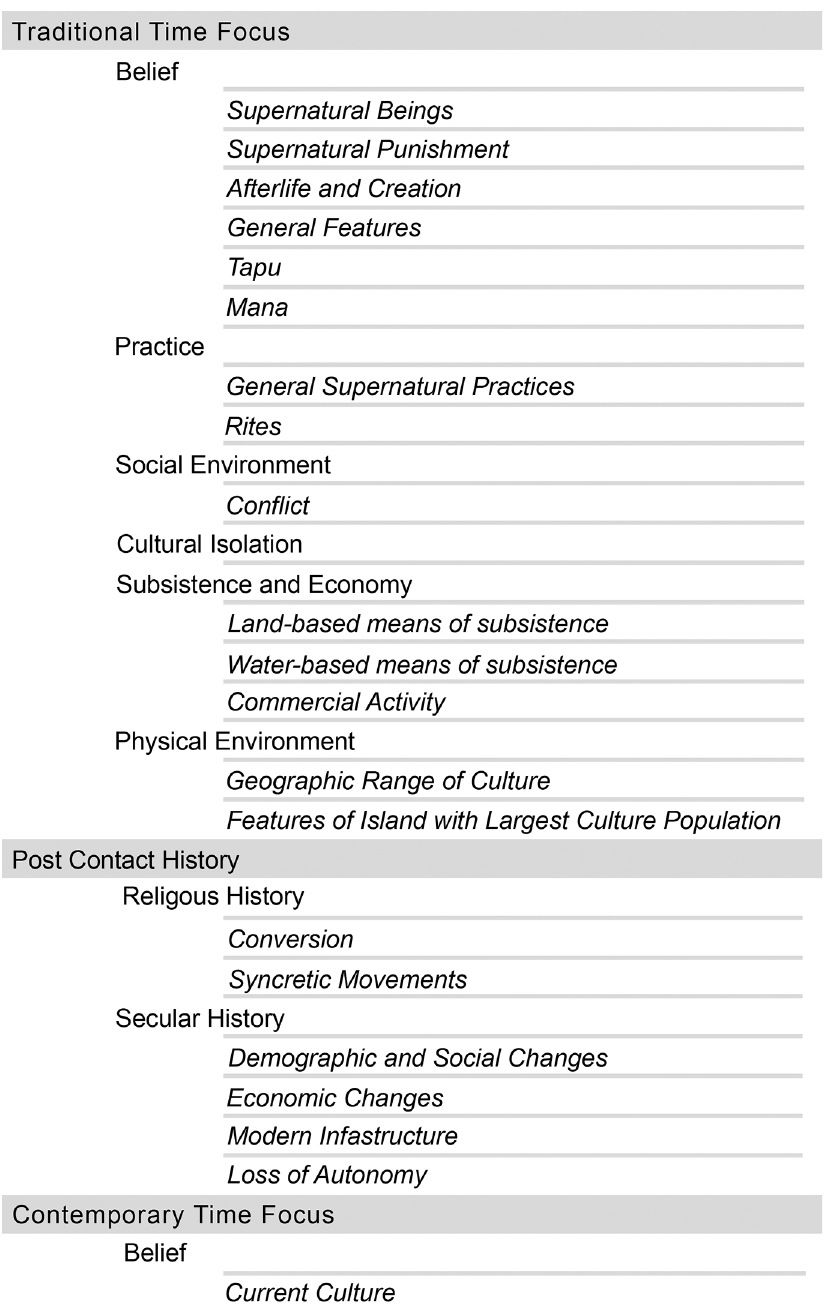
Fig 1. Pulotu Variable Structure. Organisation of variables in Pulotu , structured into time foci (level 1), sections (level 2) and sub-sections (level 3).